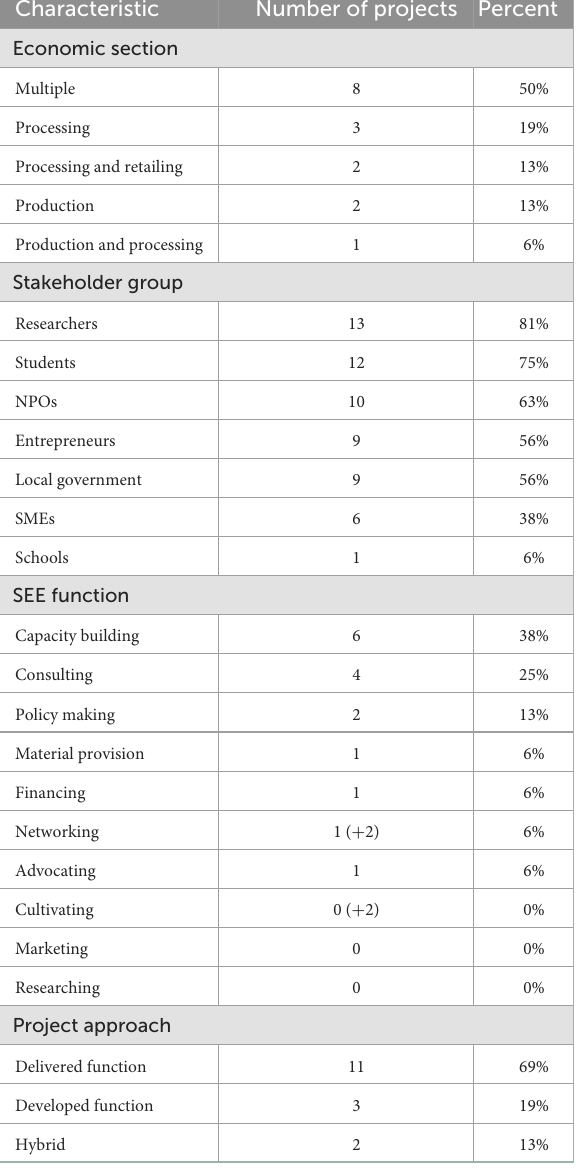
TABLE 4 Aggregate profile of the set of projects: a) economic school sector; stakeholders involved; primary SEE function; and project